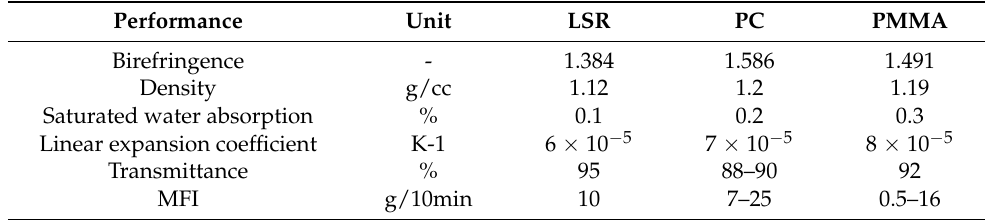
Figure 3. PVT curve of model LSR-1 (LSR material is manufactured by CAE). Table 1. Comparison of three optical polymer materials.